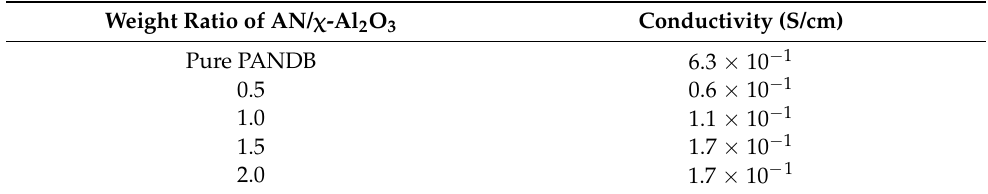
Table 1. Influence of the weight ratio of AN/ χ -Al 2 O 3 on the electrical conductivity of the conducting PANDB/ χ -Al 2 O 3 core-shell nanocomposites.